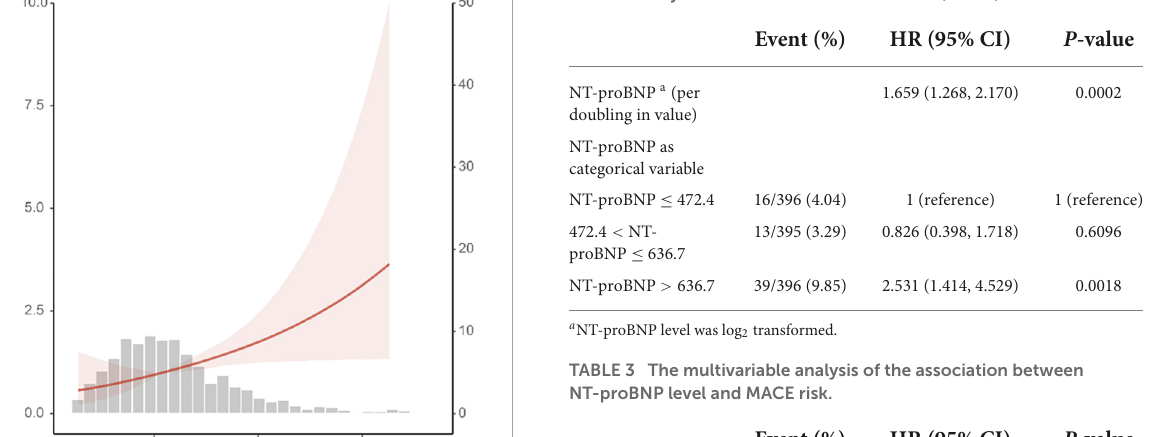
TABLE 2 A univariate analysis of the association between NT-proBNP level and major adverse cardiovascular event (MACE) risk.